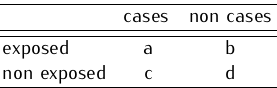
Protective systems